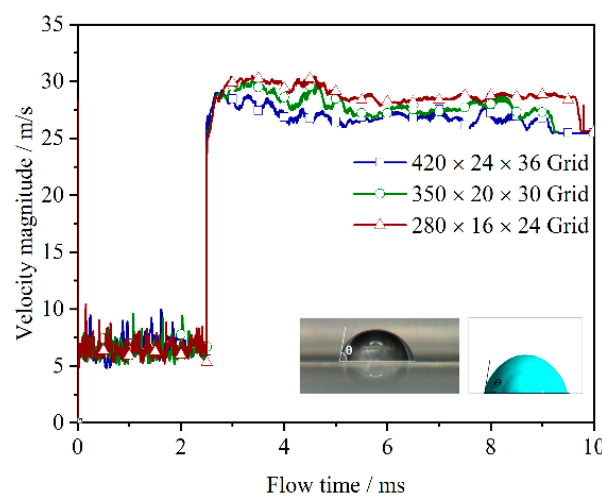
Figure 2. Result of grid sensitivity